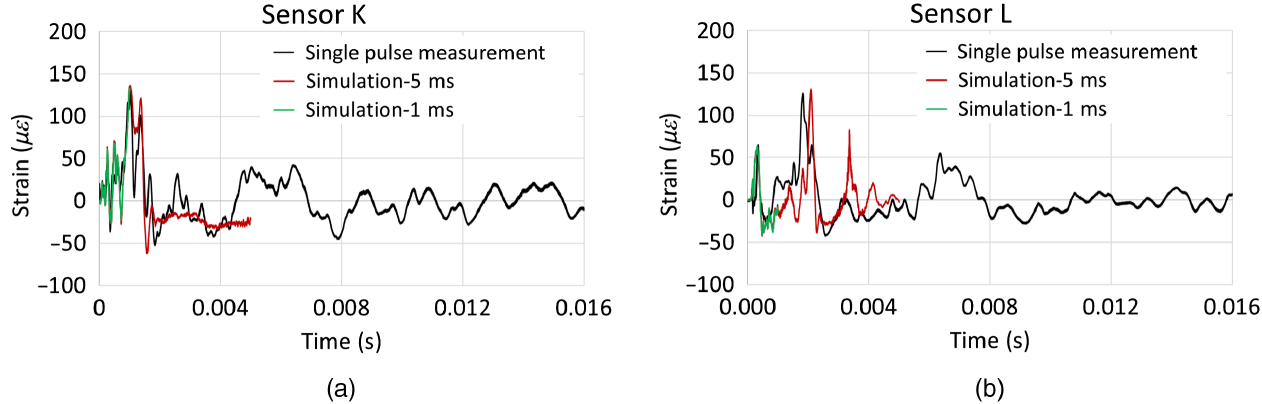
FIG. 25. Strain response from example pulses at locations K (a) and L (b) for 16 ms.